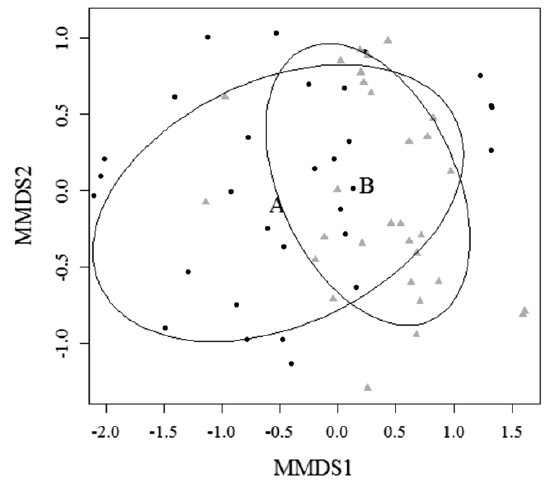
Fig. 1 - Final ordination of the 60 plots. Black dots represent the plots at site A and gray triangles are plots at site B. Gauss ellipses outline each site’s data variation, as shown by letters A and B.